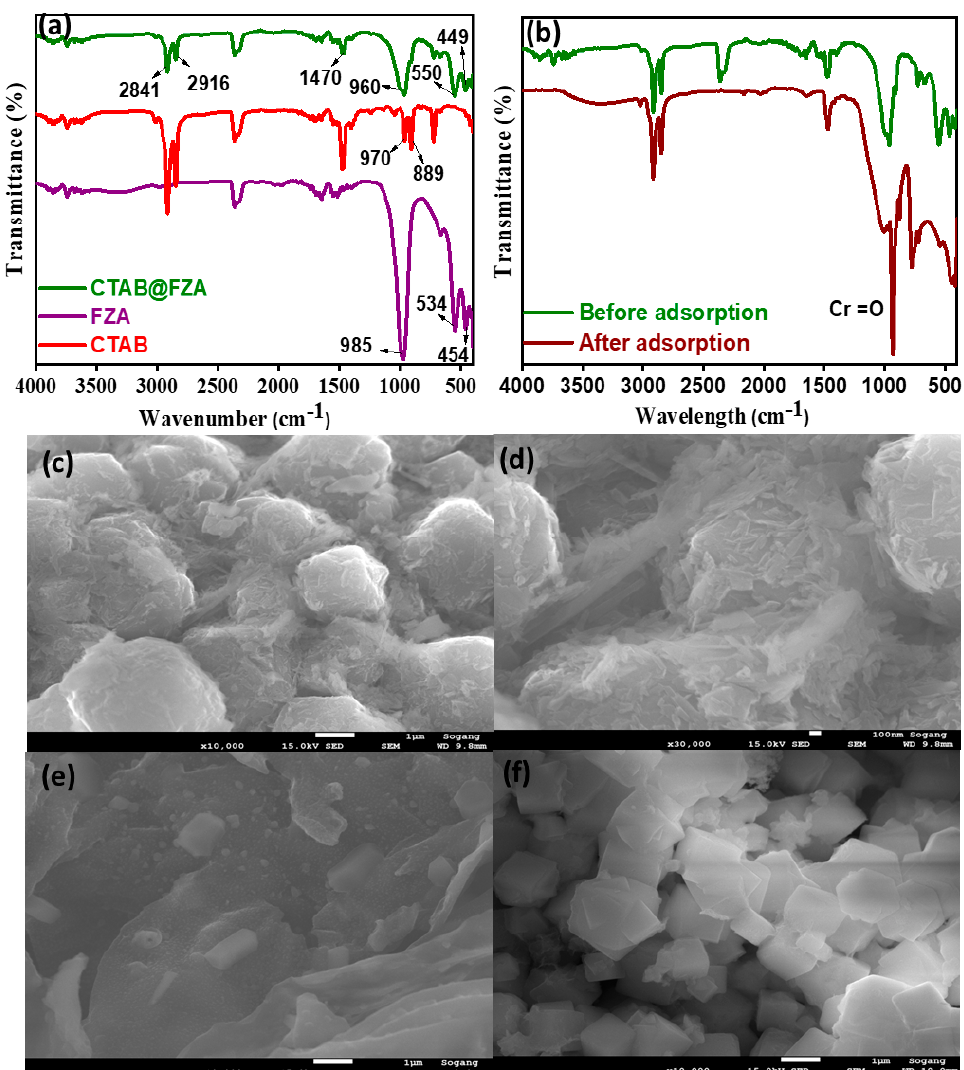
Figure 3. ( a ) FTIR spectra of CTAB@FZA and FZA; ( b ) Before and after Cr(VI) adsorption of CTAB@FZA; ( c – e ) scanning electron microscope (SEM) images of CTAB@FZA and ( f ) FZA.